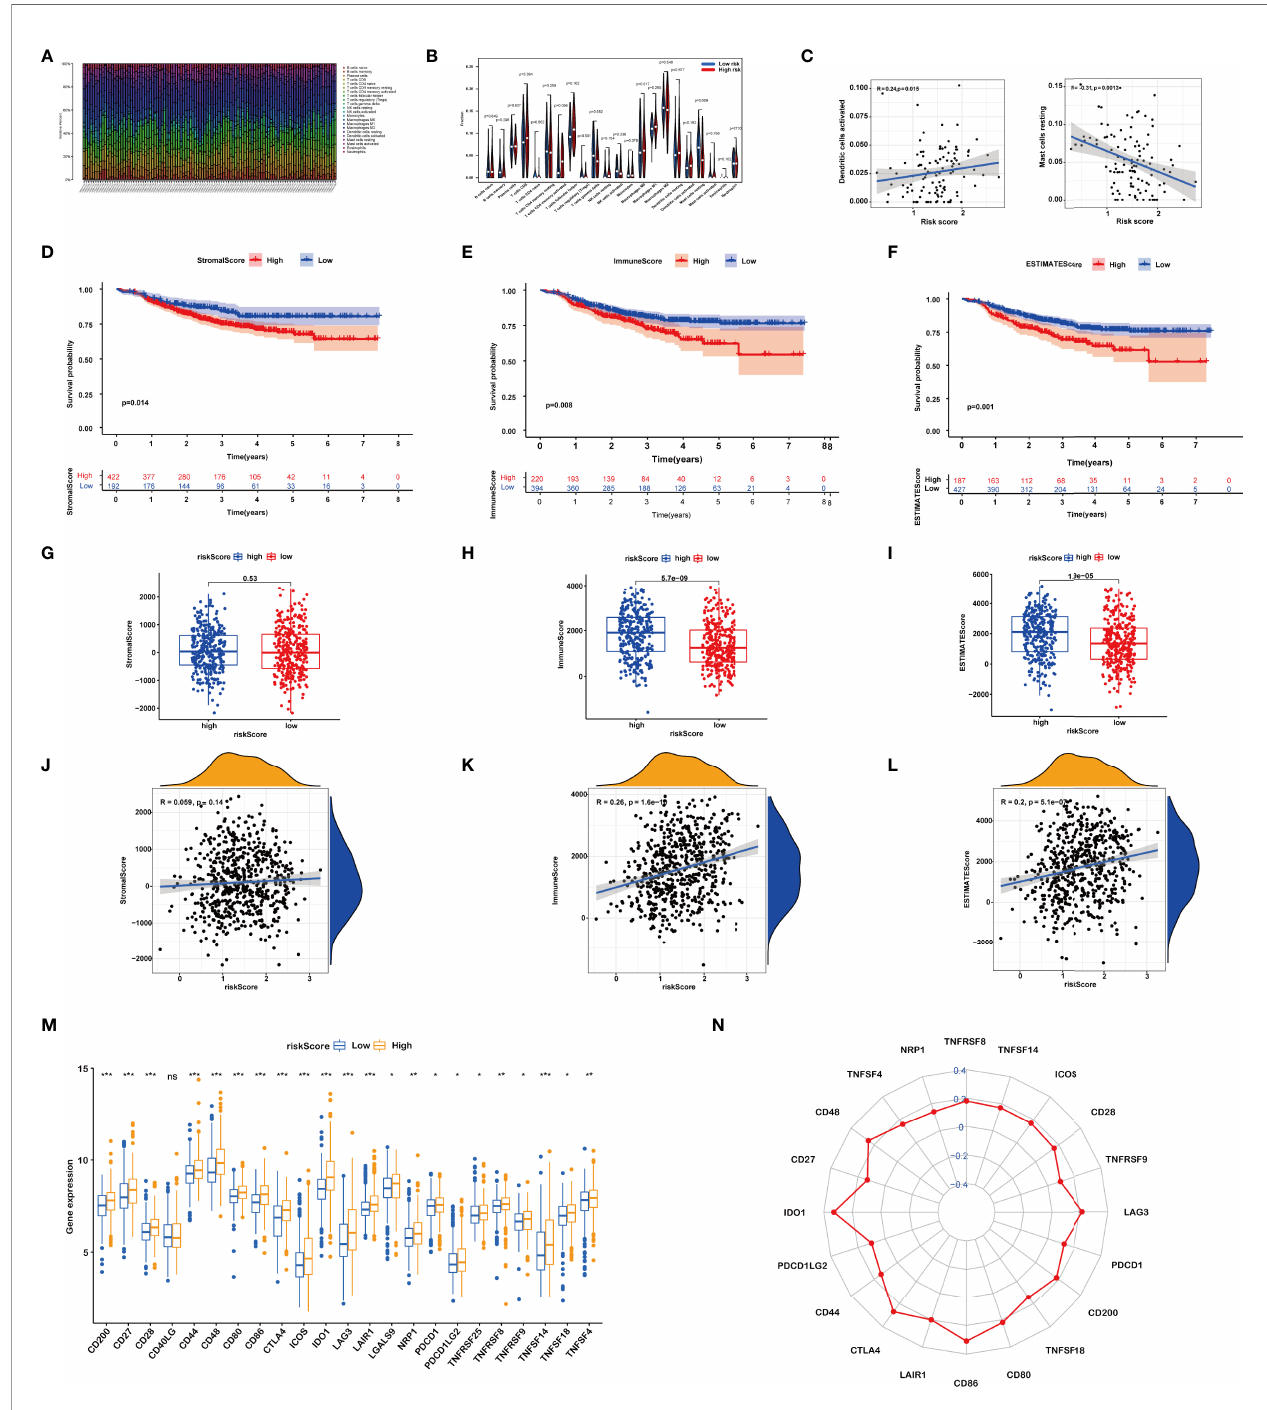
FIGURE 5 | (A) Relative percent of different immune cells in each sample. (B) Different immune cell contents in low-risk and high-risk patients. (C) Correlation between immune cells and riskScore. (D – F) Kaplan – Meier curves of the high and low stromal score (SS), immune score (IS), and estimate score (ES) group patients. (G – L) Correlation between riskScore and SS, IS, and ES. (M, N) Comparisons of the expression levels of immune checkpoints between two groups. ns, P>0.05. *, P < 0.05; **, P < 0.01; ***, P <